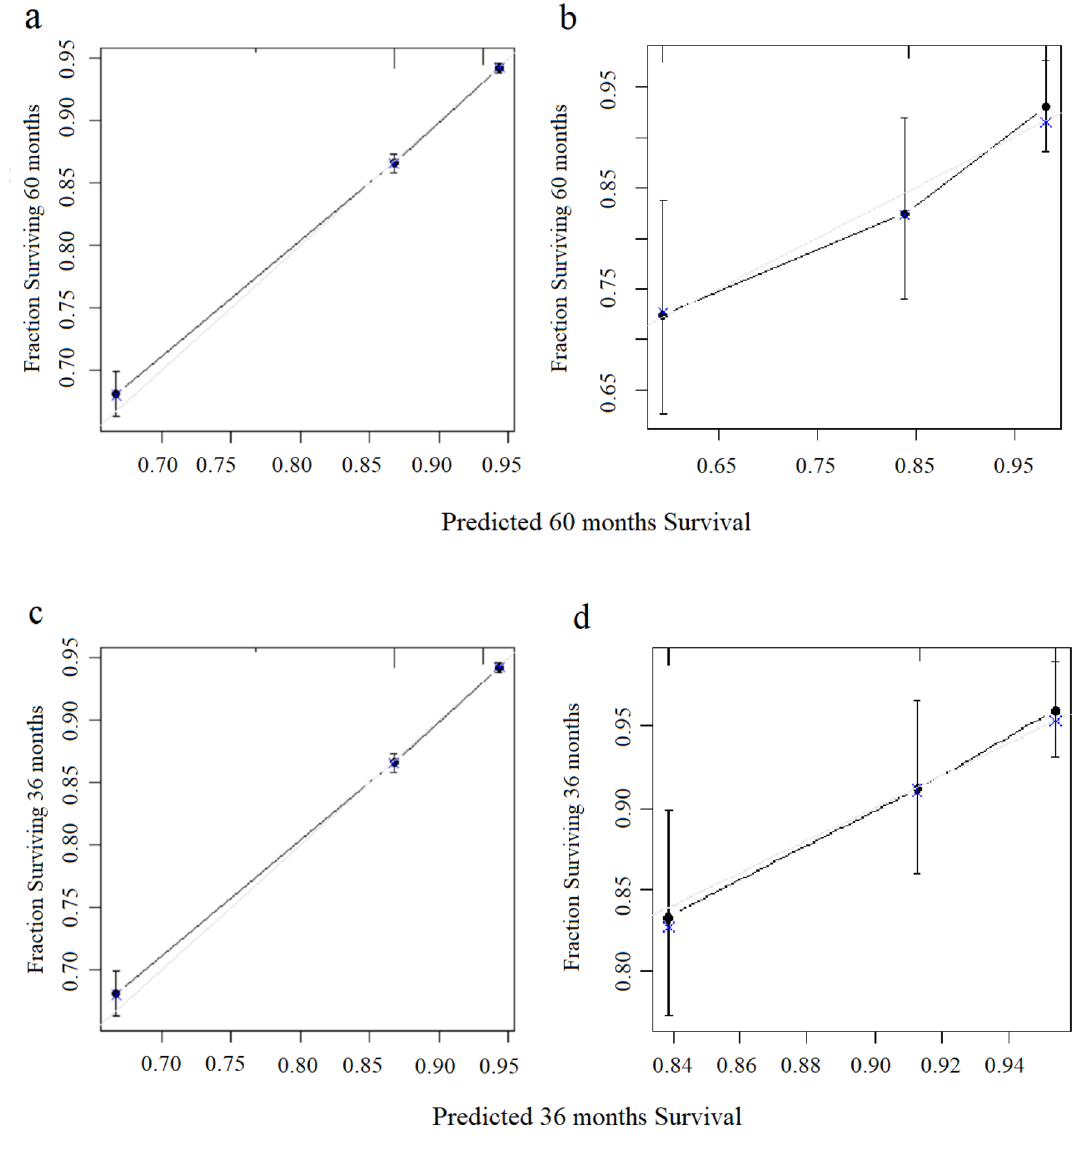
Figure 7. The calibration curves of the mStage. ( a ) Calibration curves for 5-year CSS in the development cohort. ( b ) Calibration curves for 5-year CSS in the validation cohort. ( c ) Calibration curves for 3-year CSS in the development cohort. ( d ) Calibration curves for 3-year CSS in the validation At present, the number of LNE has been shown to be an independent prognostic factor in multiple cancer types, especially in CC. Higher LNE has been associated with improved survival of pN0 CC patients but the mechanism of the relationship between the two is unclear 6,9,14 . Several hypotheses have been proposed. One possible reason is that the greater the number of LNE is associated with a greater chance of a positive node being examined and a more accurate tumor stage 15,16 . Assessing the number of LNE helps with reducing the likelihood of misclassifying stage III disease as stage I or II and improve prognosis, particularly for pN0 CC patients 17–19 . In addition, an increase in the number of LNE may be an indicator of better treatment, including complete tumor resection and adequate pathological evaluation. Another explanation is that the increase in the number of nega- tive lymph nodes indicates a stronger immune response. Once the immune system detects the presence of tumor cells, local lymph nodes will increase, and more lymph nodes will be easier to be examined in postoperative pathology. Studies have found that LNE are correlated with local neutrophil and lymphocyte infiltration by ana- lyzing the tumor microenvironment 5 . All the above studies proved the relationship between LNE and prognosis through data analysis, but did not specify the optimal stratification of LNE in pN0 CC patients. In this study, the optimal stratification of LNE for CSS was achieved by the X-tile software (N0a: LNE ≥ 26, N0b: LNE = 11–25 and N0c: LNE ≤ 10) and the Kaplan–Meier survival analysis results showed that there were significant differences in prognosis among the three LNE groups (P < 0.001) that proves that our results are meaningful.